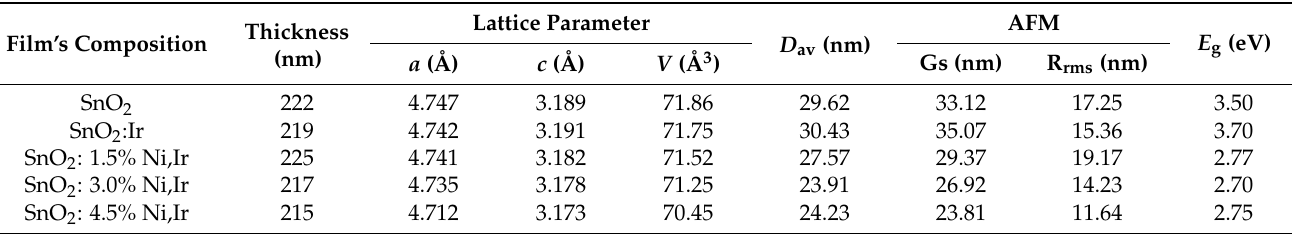
Table 1. Films’ thicknesses, XRD data (lattice parameters a and c and volume of the unit cell V), and crystallite size D av . AFM measurements (grain size, Gs, and roughness, R rms ) and the direct optical bandgap ( Eg ) of the films) are also